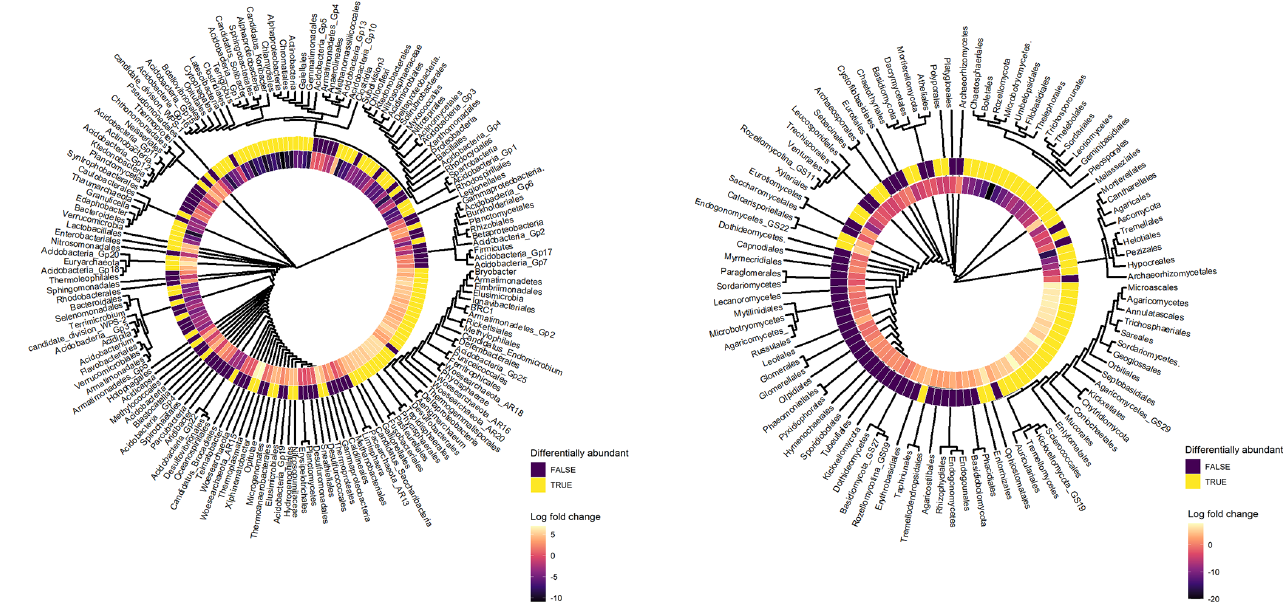
Figure 6. Cluster dendrograms of bacterial and fungal orders based on their bias-adjusted abundances (ANCOM-BC analysis). Hierarchical clustering was performed on Euclidean distances of bias-adjusted abundances using the average linkage method. The log-fold change (LFC) value of each taxon between topsoil and subsoil is displayed. Taxa with positive LFC values were higher in subsoils and taxa with negative LFC values were lower in subsoils. The statistical significance of each taxa’s differential abundance between topsoil and subsoil is displayed, with TRUE = p < 0.05 and FALSE = p >